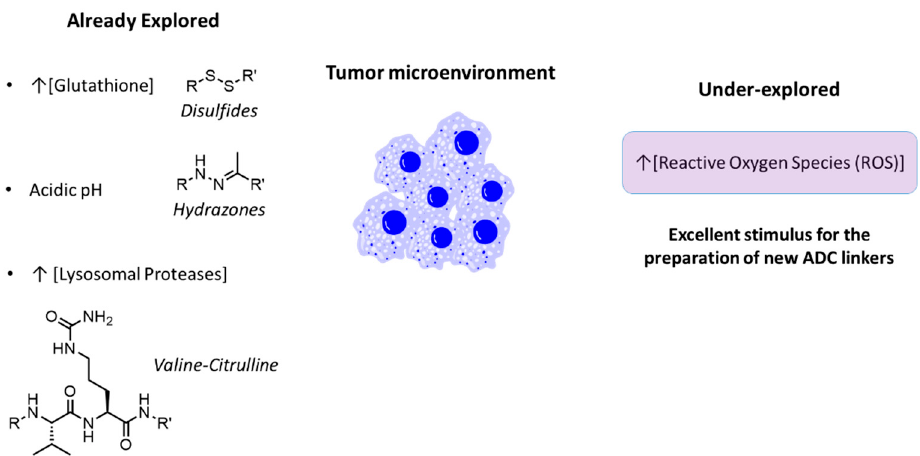
Figure 16. Contrary to glutathione, acidic pH and proteases, the increased concentration of ROS in the tumor microenvironment has not been explored as a stimuli for the preparation of ADCs.